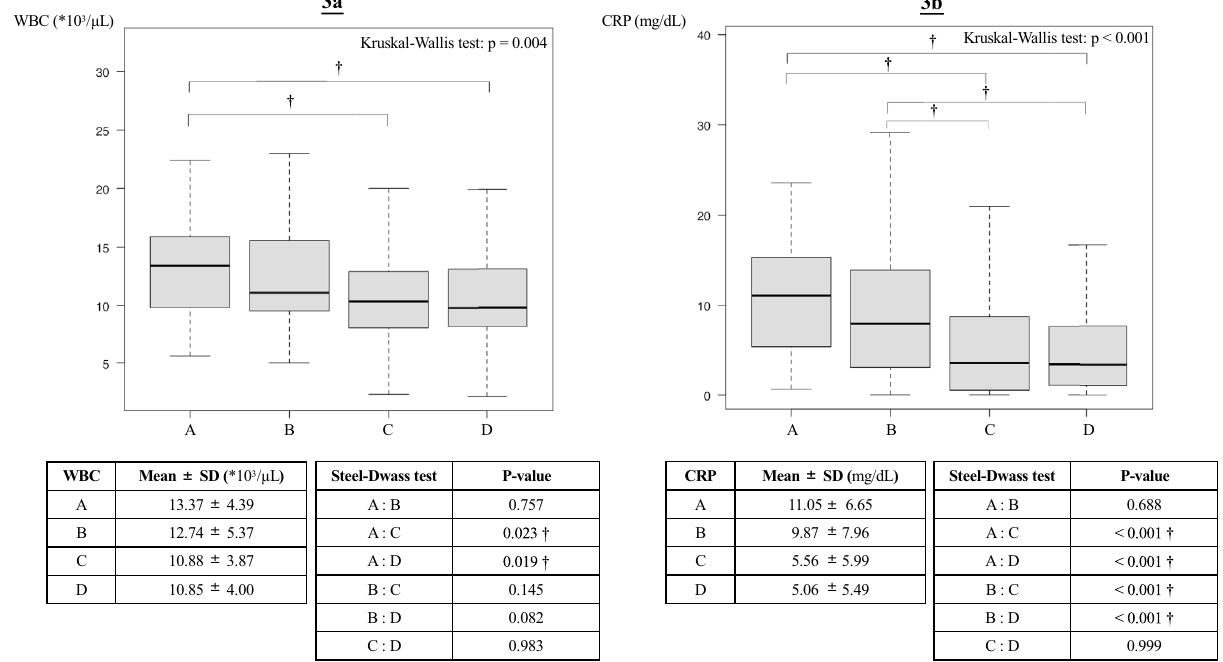
Figure 3. Result of post-hoc analysis. The four groups are as follows: A, AHT(+) and delirium(+); B, AHT(−) and delirium(+); C, AHT(+) and delirium(−); D, AHT(−) and delirium(−). The WBC count and CRP values were the highest in three days after injury. The vertical dashed lines between the horizontal bars show 95%CIs. The black thick horizontal bars are the mean value, and gray boxes are SDs. † The results were statistically significant based p -value < 0.05. We performed the Kruskal–Wallis test, a non-parametric analysis, because the homoscedasticity of the data rejected. ( a ) Significant differences were observed between groups A and C and groups A and D (Kruskal–Wallis test: p = 0.004). ( b ) Significant differences were observed between groups A and C, A and D, B and C, and B and D (Kruskal–Wallis test: p < 0.001). AHT, antihypertensive drug; CI,